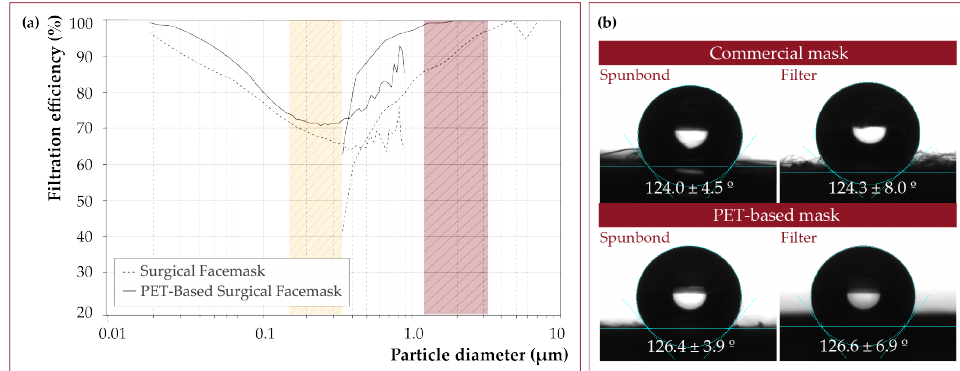
Figure 10. ( a ) Filtration efficiency of a PET-based surgical mask prepared in this work compared to a commercial surgical mask. The polydispersity range of particles used in the EN 14683:2019 surgical mask test is marked in red, and the range used in the EN 149:2001 standard, applicable to FFP2 (similar to KN95) and FFP3 (similar to KN99) masks, is marked in yellow. Labels for filtration efficiency at specific diameters (100, 300, 500, and 700 nm) can be seen on the graph. ( b ) The contact angle of the materials obtained compared to a commercial surgical